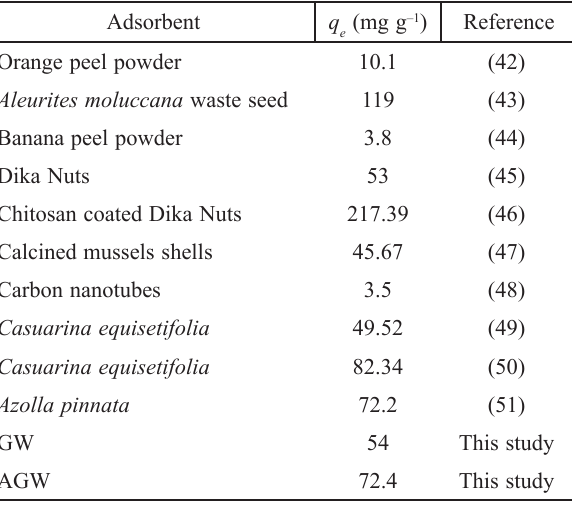
Table 7 – Comparison of adsorption capacities of various synthesized adsorbents